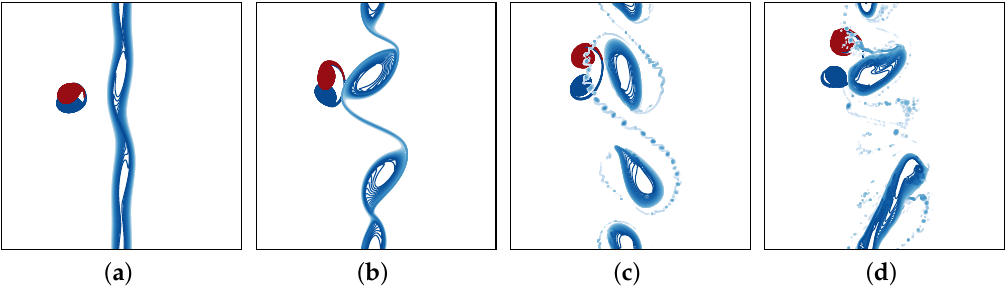
Figure 14. Case 5: effect of increasing the strength of the filament. Here Λ = 2, which is 5 times larger than in the default case 1, keeping all other parameters the same. Top view of the flow showing contours of buoyancy and PV at t = 5, 7, 9 and 11 from ( a ) to ( d